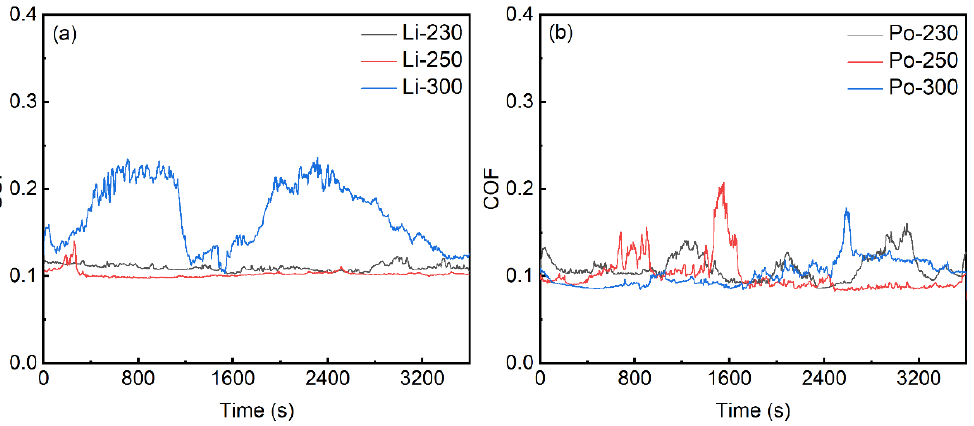
Figure 12. Coefficient of friction of greases with different consistencies: ( a ) lithium greases, ( b ) polyurea greases.